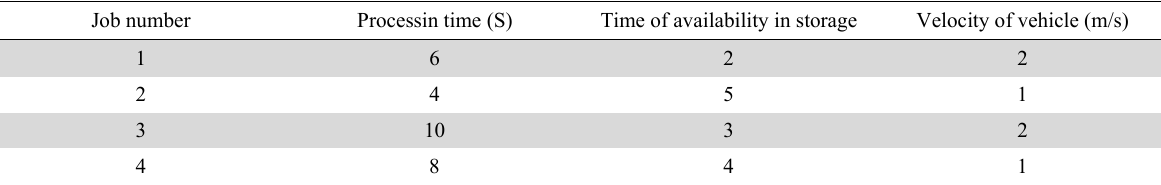
Input data for discrete ScheLoc